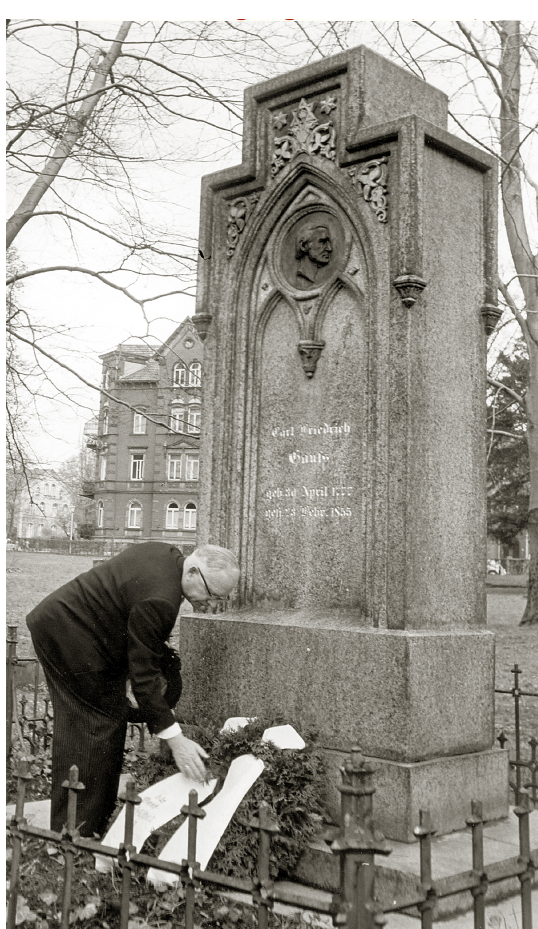
Figure 3. The geophysicist Julius Bartels, the first president of the Gauss Society, laying a wreath at the grave of Gauss in 1963 (pho- tograph from the Gauss Society archives).